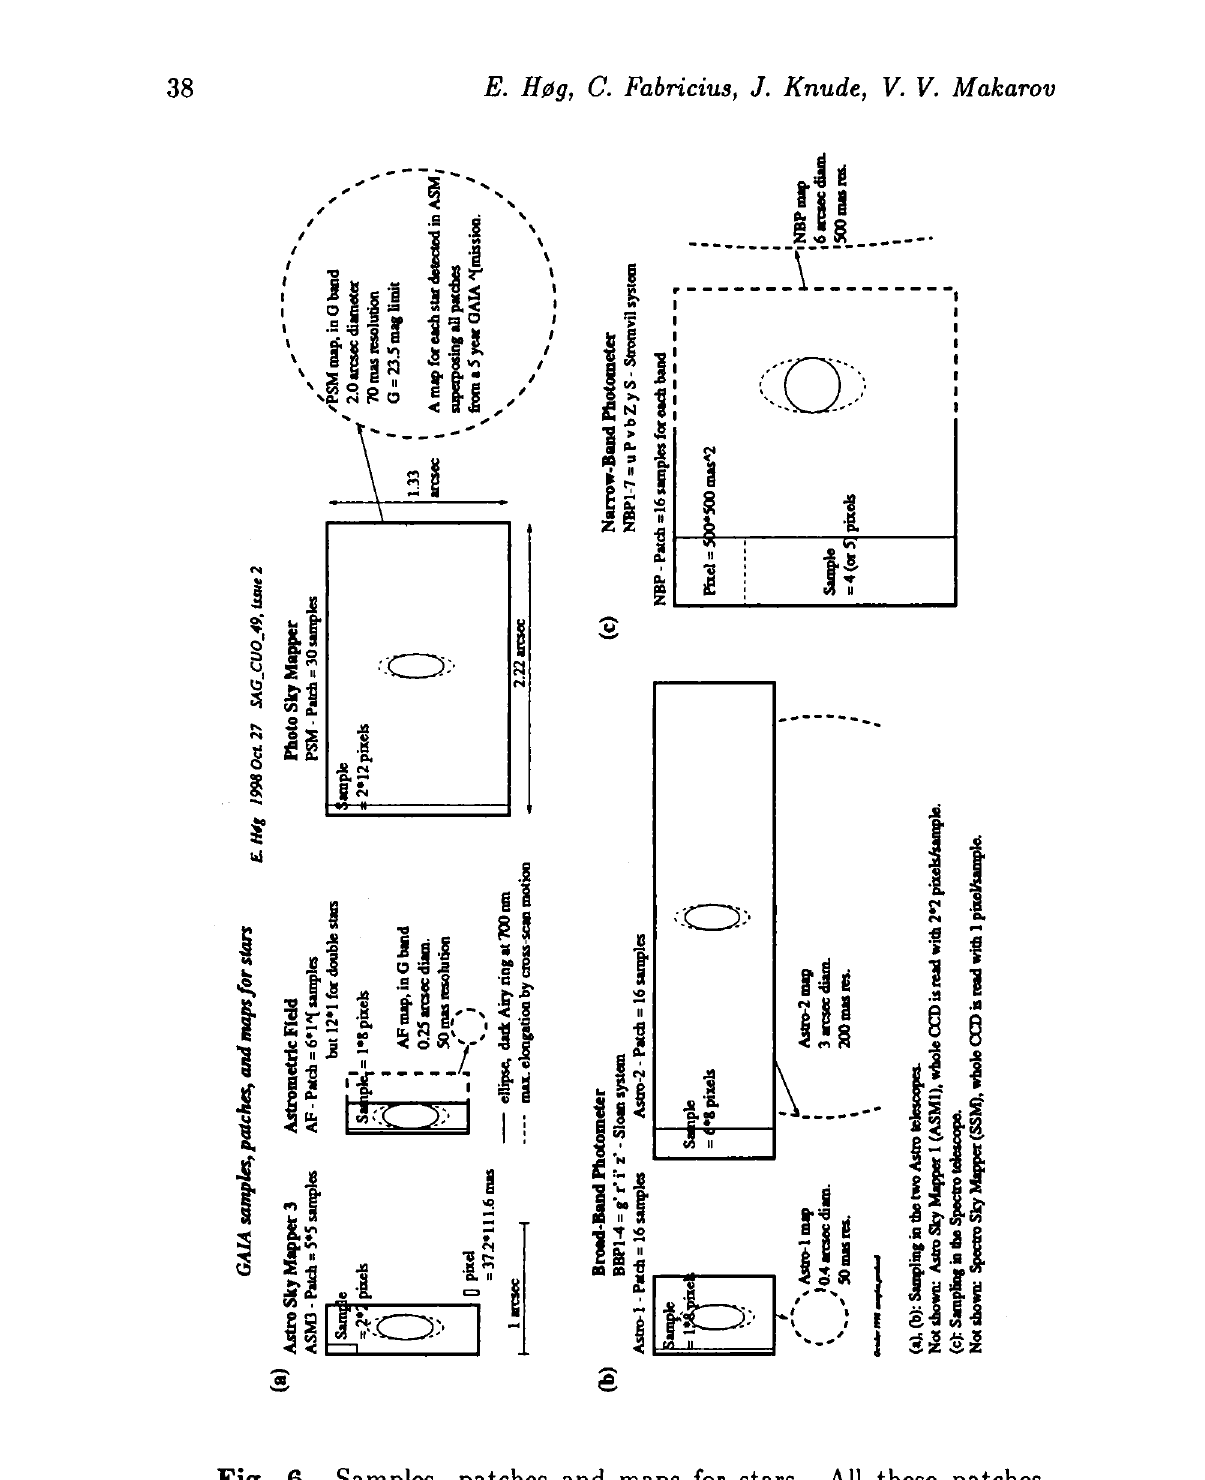
Fig. 6. Samples, patches and maps for stars. All these patches, except those from the ASM3, will be transmitted to